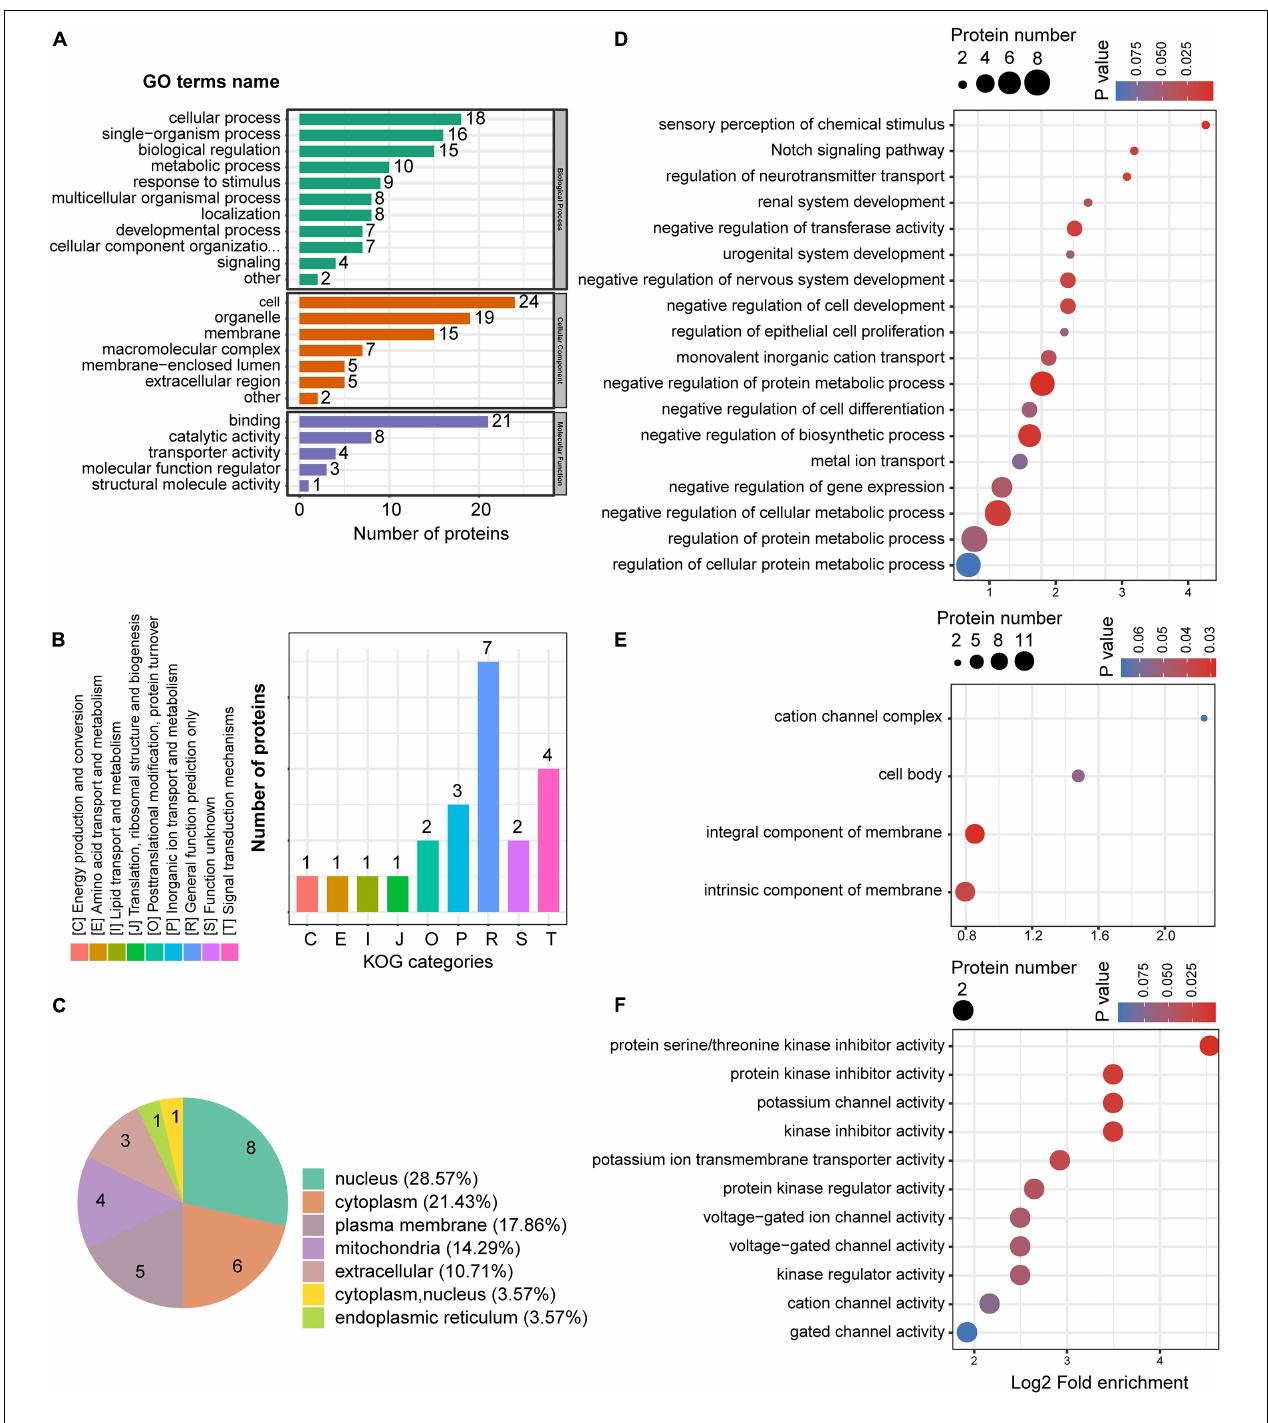
FIGURE 6 | The GO enrichment of up-regulated proteins in the mPFC. (A) GO annotations of upregulated proteins in the mPFC. (B) Cluster of orthologous groups for enkaryotic complete genomes (KOG) classification of upregulated proteins. (C) Subcellular localization analysis of upregulated proteins. (D–F) GO enrichment analysis according to the upregulated proteins in the mPFC. Biological process (D) , cellular compartment (E) , and molecular function (F) .